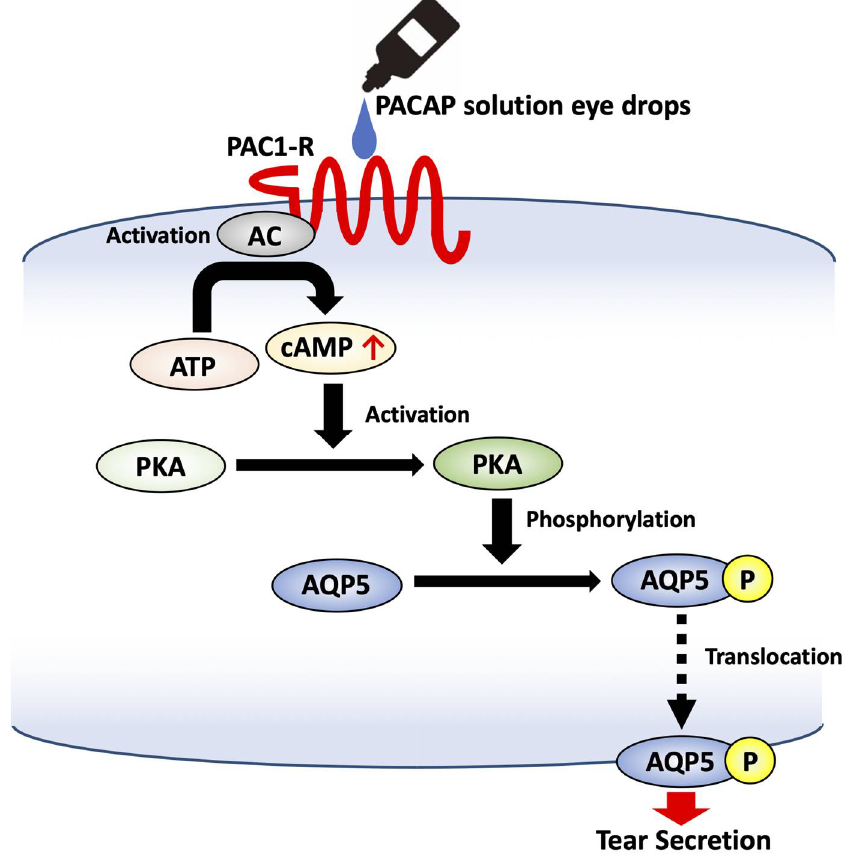
Figure 1. Schematic diagram of signal transduction for PACAP in the lacrimal gland. PACAP induces tear secretion via an AC/cAMP/PKA cascade, which in turn stimu- lates AQP5